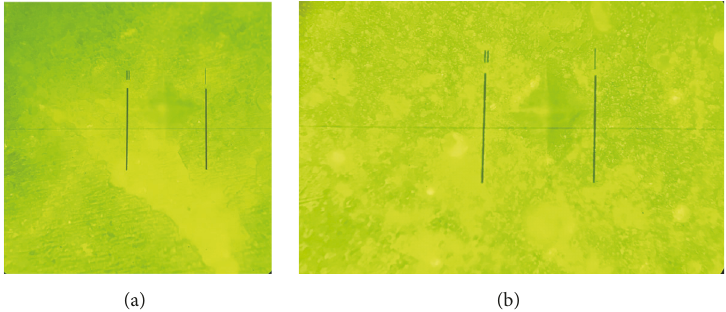
Figure 1: Representative images ( × 40 magnification) of the Vickers hardness indentations on the surfaces of the tested glass ionomer cement materials. (a) Ketac Fill Plus Aplicap. (b) IonoStar